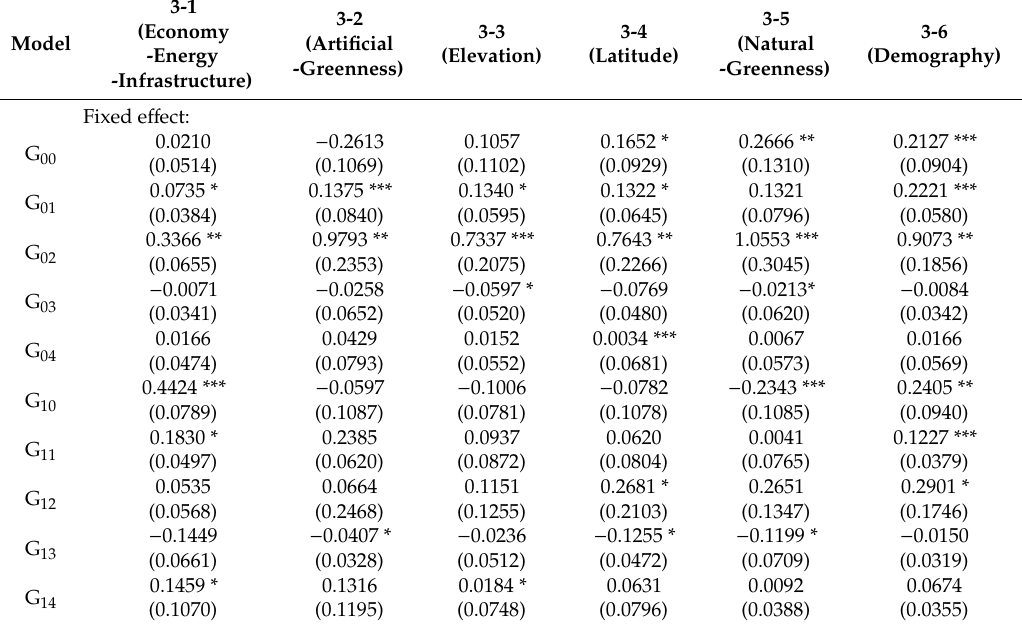
Table 5. The estimation of parameters and variance components (with standard errors) for Model 3 (Note: *, **, and *** denote the significance level at 10%, 5%, and 1%, respectively).